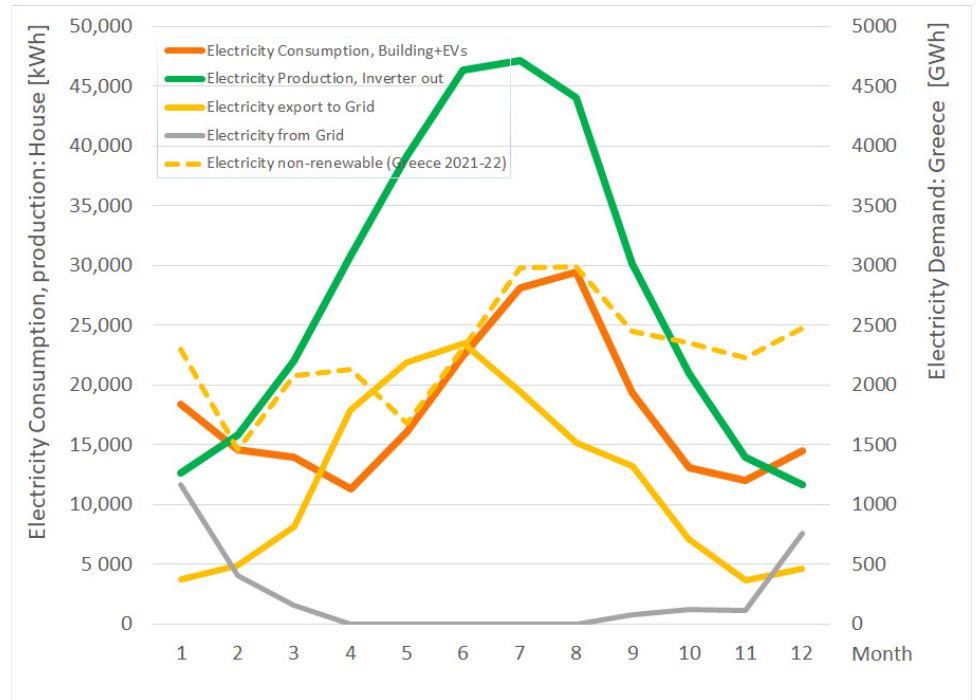
Figure 5. Monthly variation of PV electricity production, electricity consumption of the office build- ing, and charging requirements for the 40 employees’ electric cars, compared to the trend in the non- renewable monthly electricity consumption of Greece during